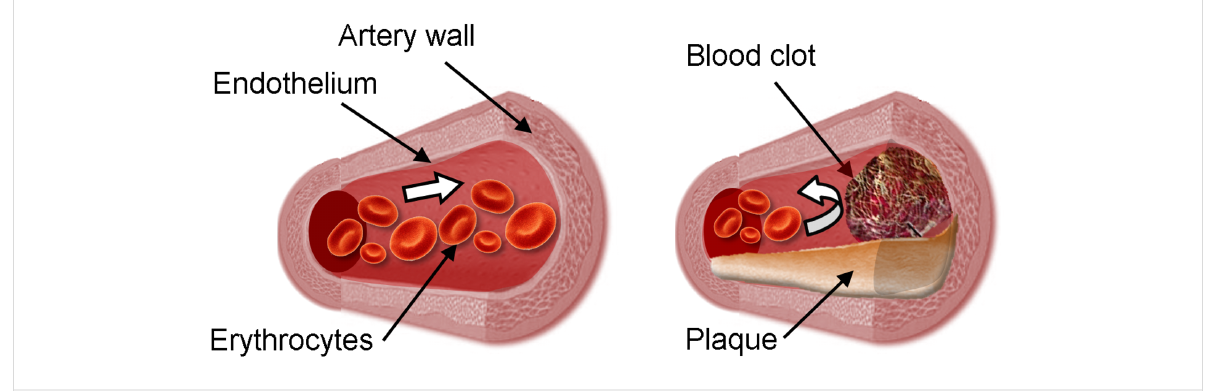
Scheme 6: Normal (left) and diseased artery